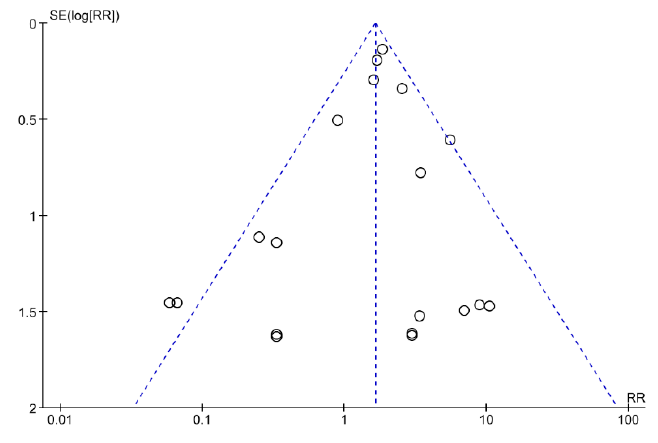
Figure 5. Funnel plot analysis for publication bias.